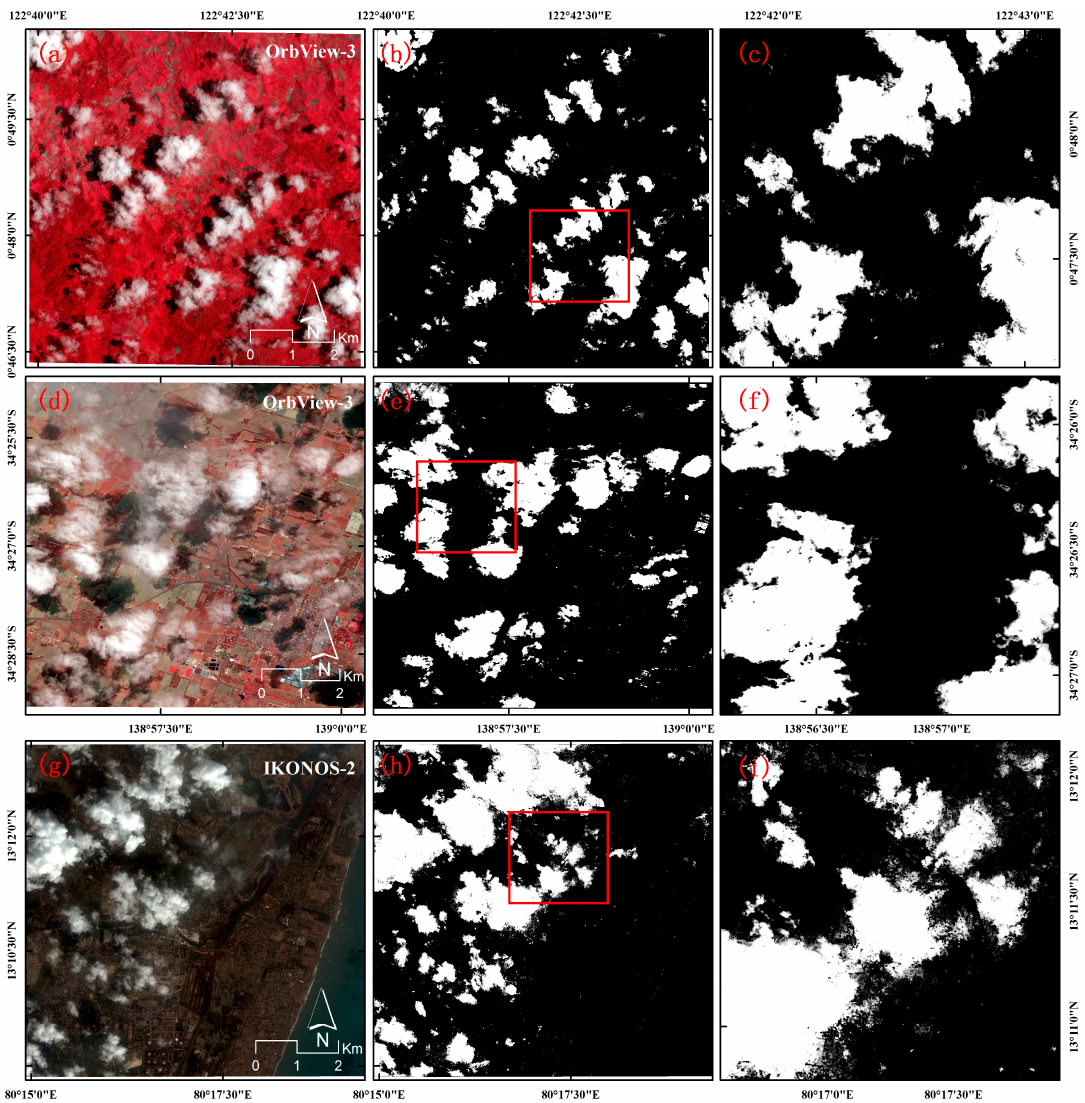
Figure 12. The origin map and classification results of two OrbView-3 images and one IKONOS-2 image: ( a – c ) the original map, cloud classification map, and the magnified area corresponds to the red line regions of cloud classification map for one OrbView-3 image, respectively; ( d – f ) for other OrbView-3 image; and ( g – i ) for IKONOS-2 image.